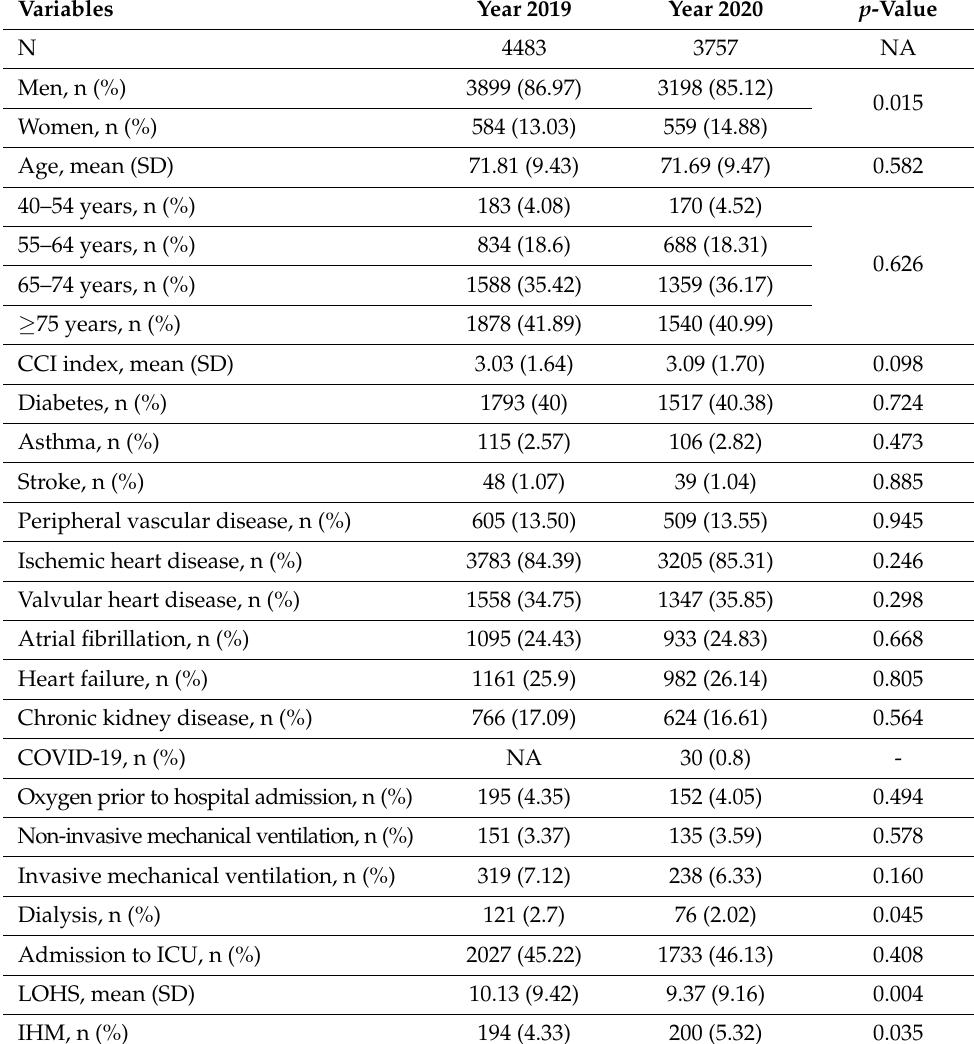
Table 1. Demographic and clinical characteristics and in-hospital outcomes of patients with chronic obstructive pulmonary disease who underwent “any cardiac procedure” in Spain in 2019 and 2020. Analysis of the Spanish National Hospital Discharge